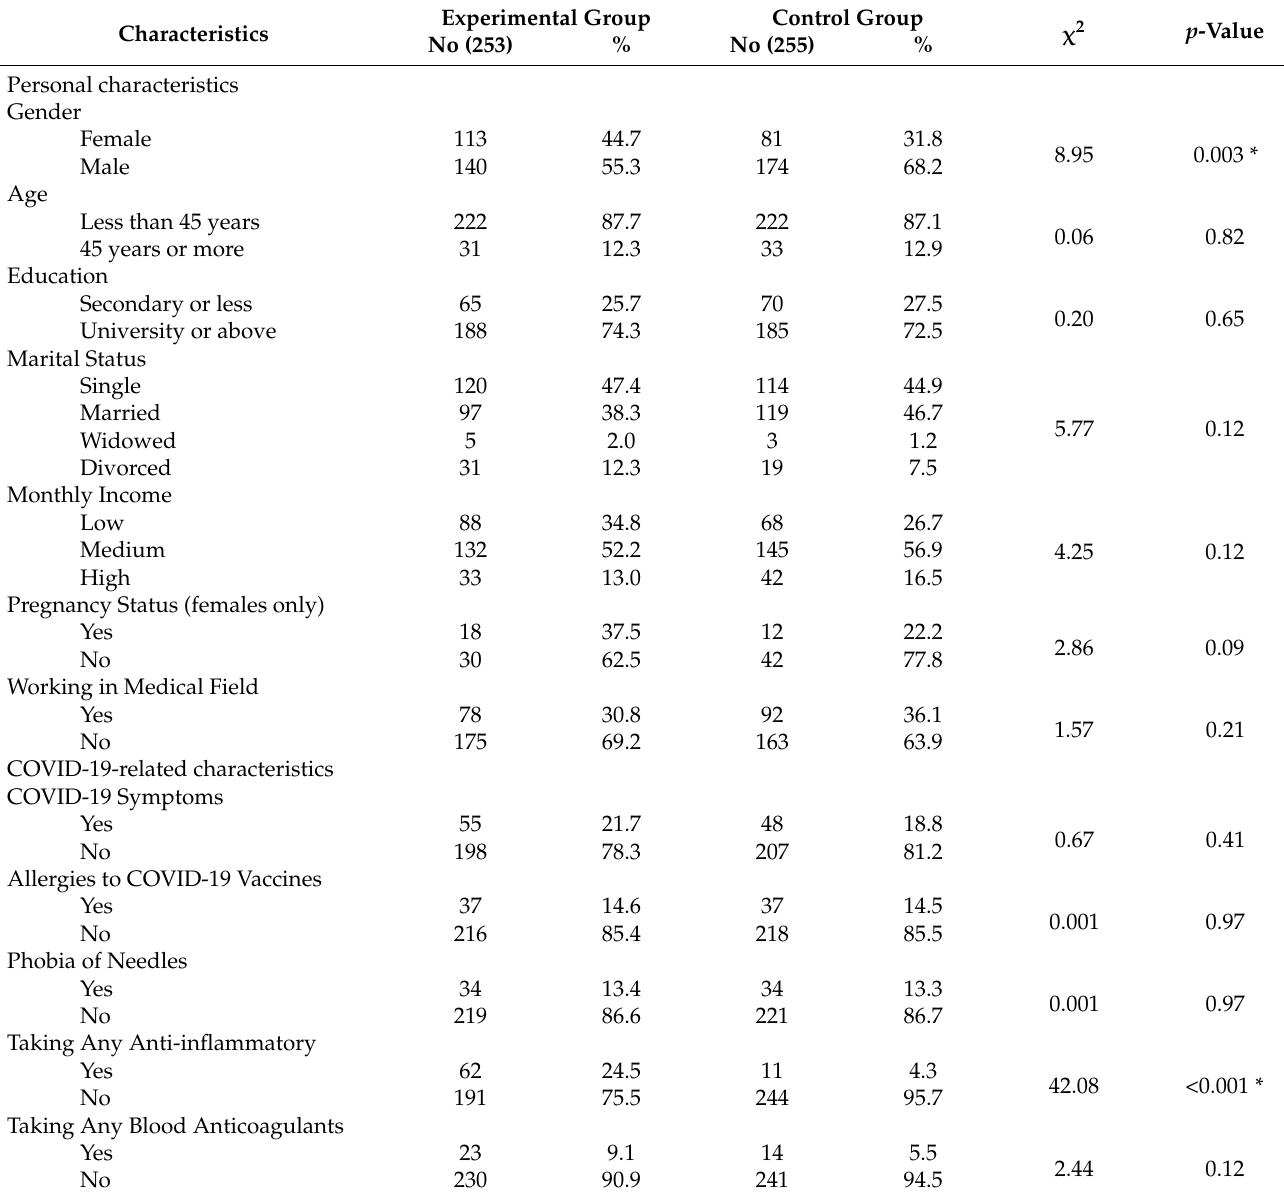
Table 1. Personal and COVID-19-related characteristics of the experimental and control